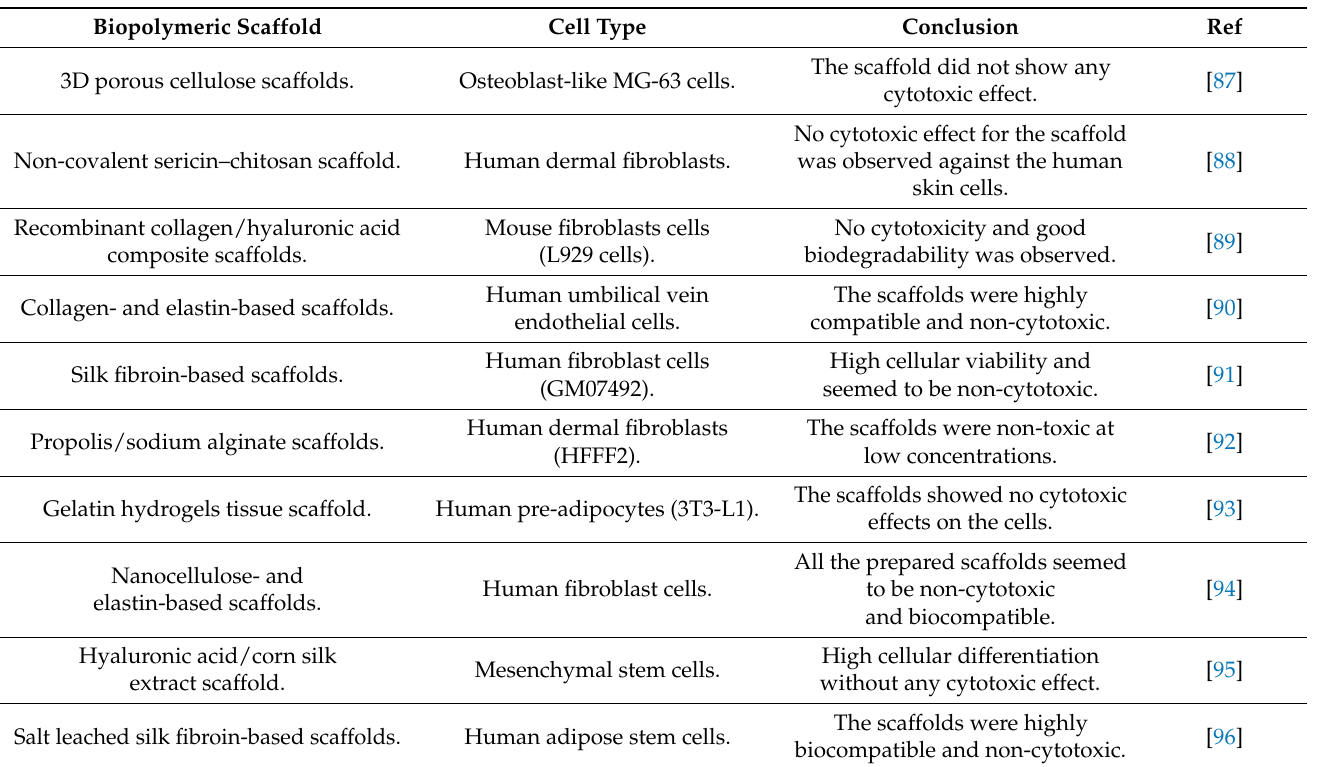
Table 2. Biocompatibility and cytotoxicity of biopolymers in tissue engineering applications. Biopolymeric